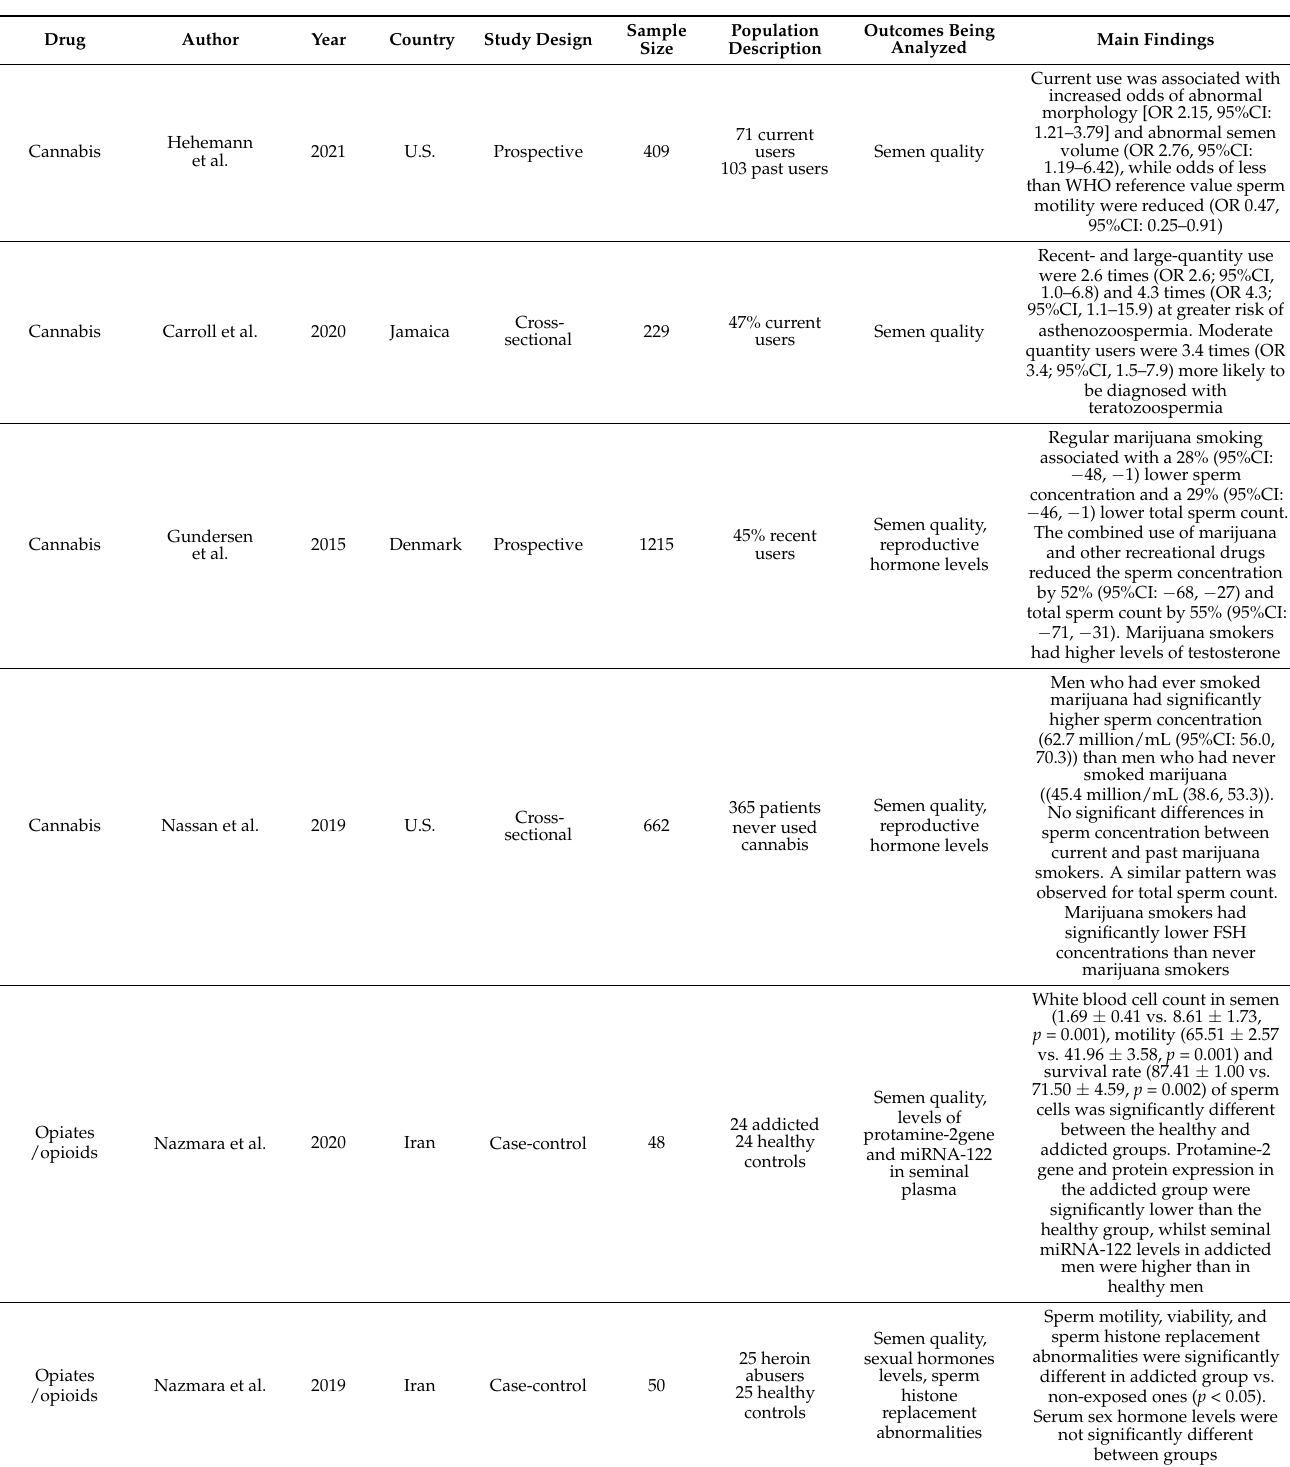
Table 1. Recreational drug (e.g., cannabis; opiates/opioids; amphetamine-type stimulants; and khat) misuse and its impact on male fertility levels: summary of most representative